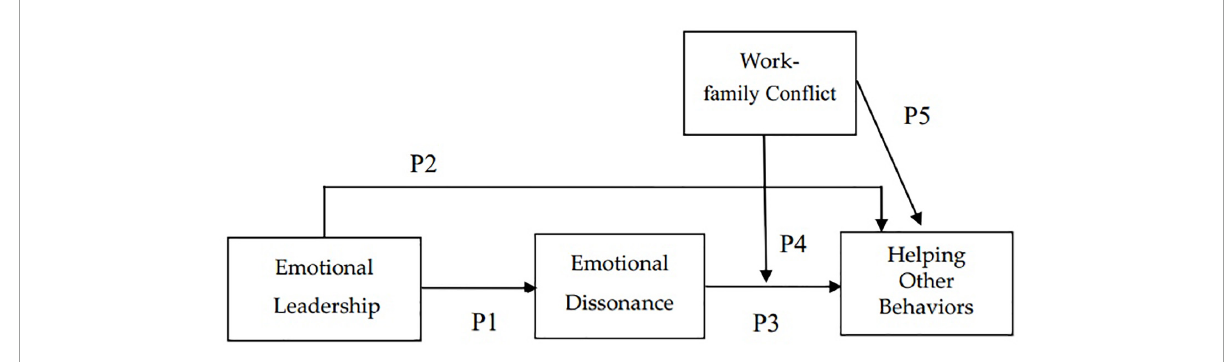
FIGURE1 A moderated mediation model of emotional